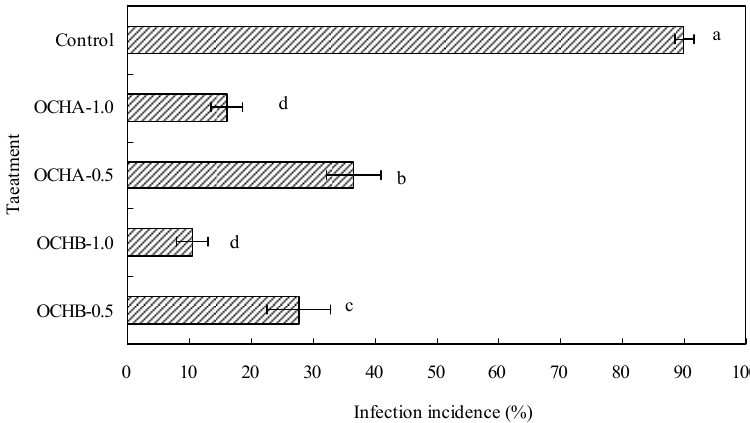
Figure 1. Protective effects of oligochitosan A (OCHA) and oligochitosan B (OCHB) on Zanthoxylum bungeanum ( Z. bungeanum ), stems against infection of Fusarium sambucinum ( F. sambucinum ). OCHA-1.0 and OCHA-0.5 represented concentrations of OCHA of 1.0 and 0.5 mg/mL, respectively. OCHB-1.0 and OCHB-0.5 represented concentrations of OCHB of 1.0 and 0.5 mg/mL, respectively. The error bars represented standard deviations of the means from three independent samples. Values followed by different letters (i.e., a, b, c and d) indicated significant differences among the different treatments at p = 0.05 level.